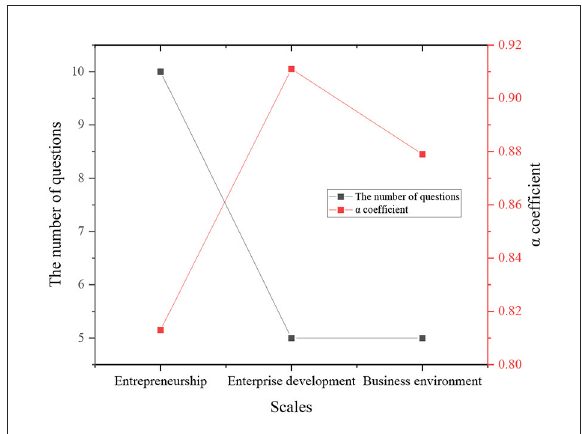
FIGURE6 Internal consistency reliability of the Scale’s α coefficient